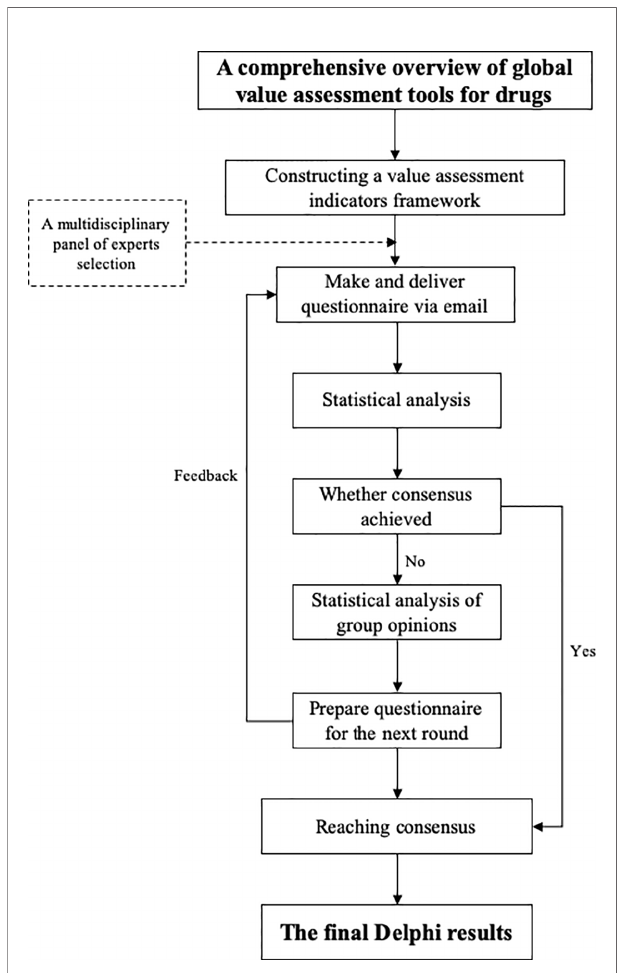
FIGURE 2 | Conceptual framework of value